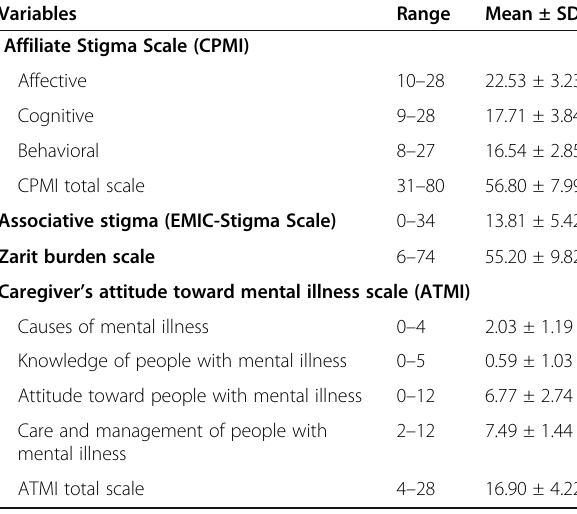
Table 3 Stigma, burden, and attitude toward mental illness of the caregivers, Assiut, Egypt,